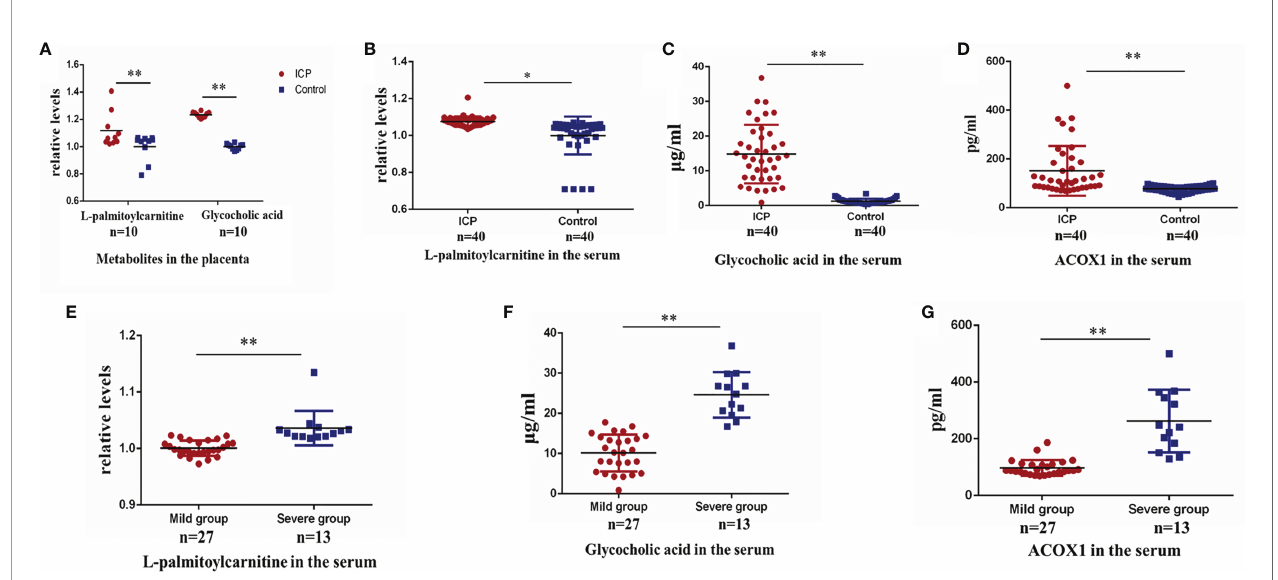
FIGURE 3 | Validation of alteration in protein and metabolite levels in late pregnancy. (A) Placental levels of L-palmitoylcarnitine and glycocholic acid in ICP and control groups (P=0.006, P=0.000, respectively); (B) serum levels of L-palmitoylcarnitine in ICP and control groups (P=0.010); (C) serum levels of glycocholic acid in ICP and control groups (P=0.000); (D) serum levels of ACOX1 in ICP and control groups (P=0.000). (E) serum levels of L-palmitoylcarnitine in mild and severe ICP groups (P=0.000); (F) serum levels of glycocholic acid in mild and severe ICP groups (P=0.000); (G) serum levels of ACOX1 in mild and severe ICP groups (P=0.000). (**P < 0.01; *P <